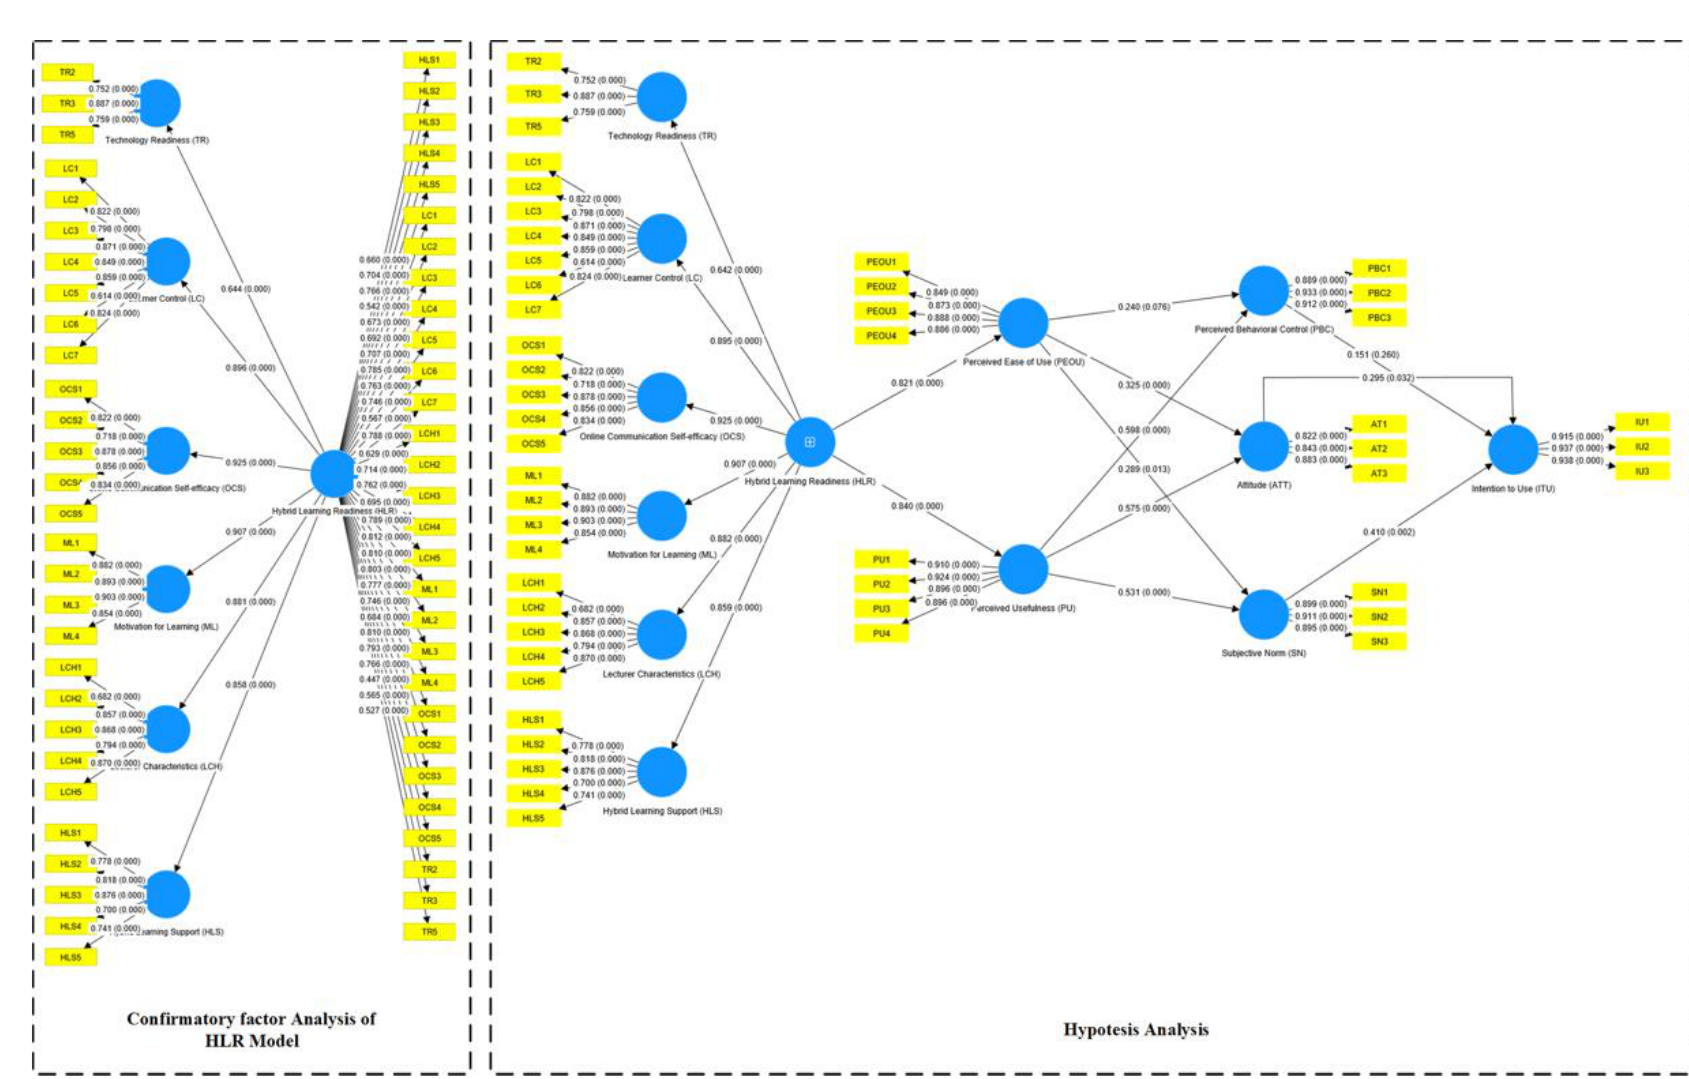
Figure 4: Model Evaluation and Hypothesis Testing; Source: Authors